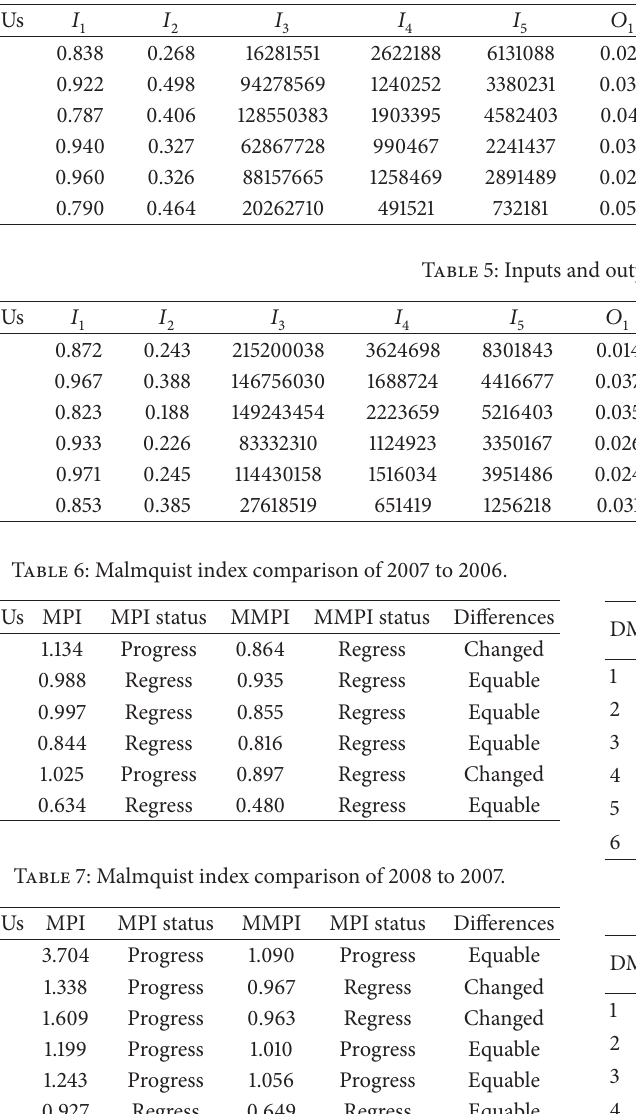
Table 4: Inputs and outputs (2008).